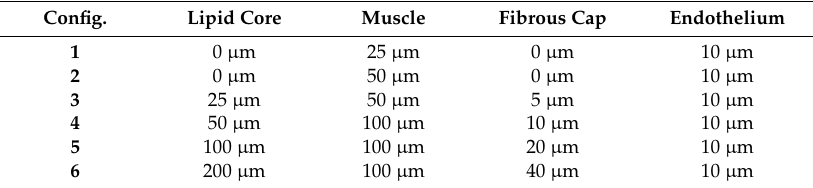
Table 2. Configurations of thicknesses for neointimal tissue layers. Config. Lipid Core Muscle Fibrous Cap Endothelium